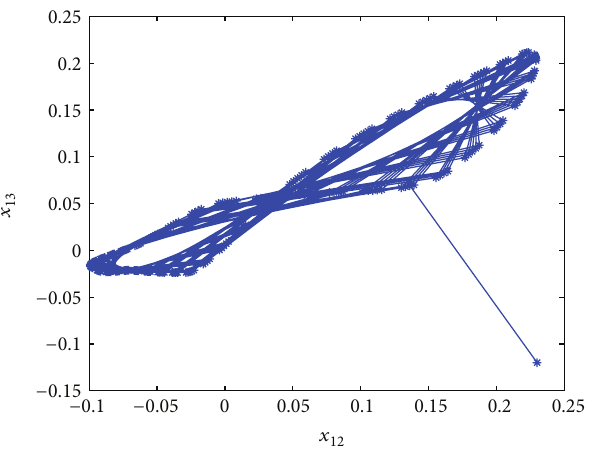
Figure 6: Phase response of state variables 𝑥 12 , 𝑥 13 in Example